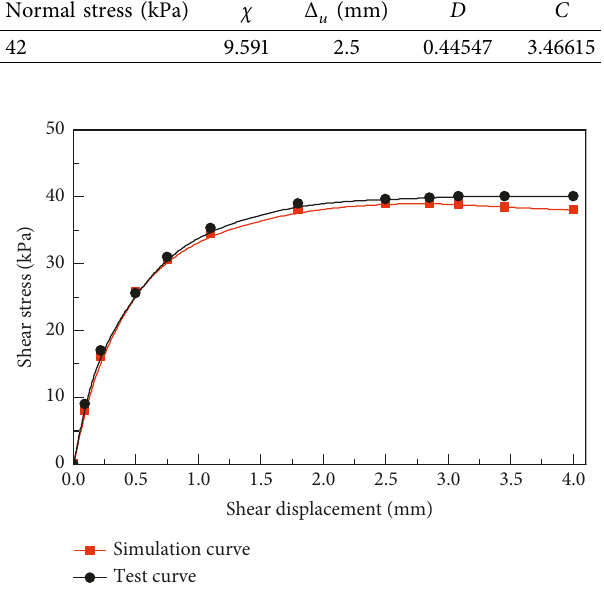
Figure 6: Simulation when the normal stress is 42kPa.